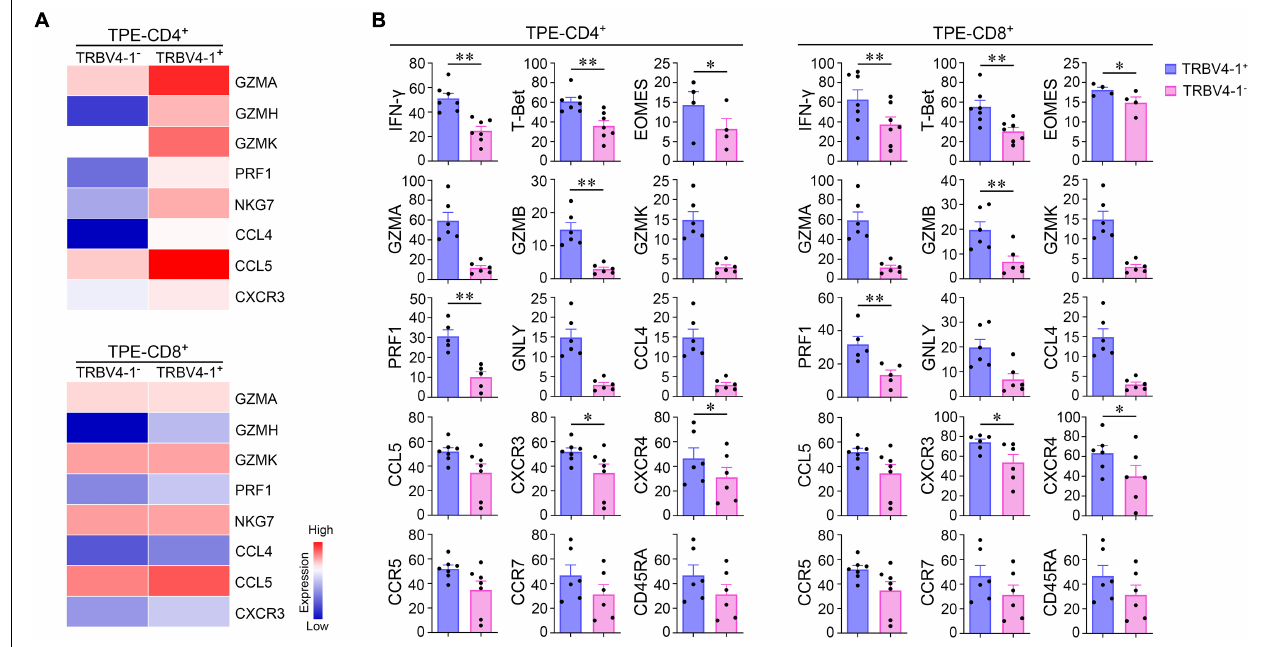
FIGURE 5 | CD1-restricted polyfunctional T cell subsets in human Mtb infection site. (A) Differential expression of cytotoxic genes from TRBV4-1 + CD4 + T cells, TRBV4-1 + CD8 + T cells, and paired TRBV4-1 − T cell subsets by scTCR-seq and sc-RNA seq. (B) The protein expression of T H 1 markers and cytotoxic associated molecules on TRBV4-1 + CD4 + T cells, TRBV4-1 + CD8 + , and paired TRBV4-1 − T cell subsets by flow cytometry. ∗ P < 0.05, ∗∗ P < 0.01, determined by paired t test. TPE, tuberculous pleural